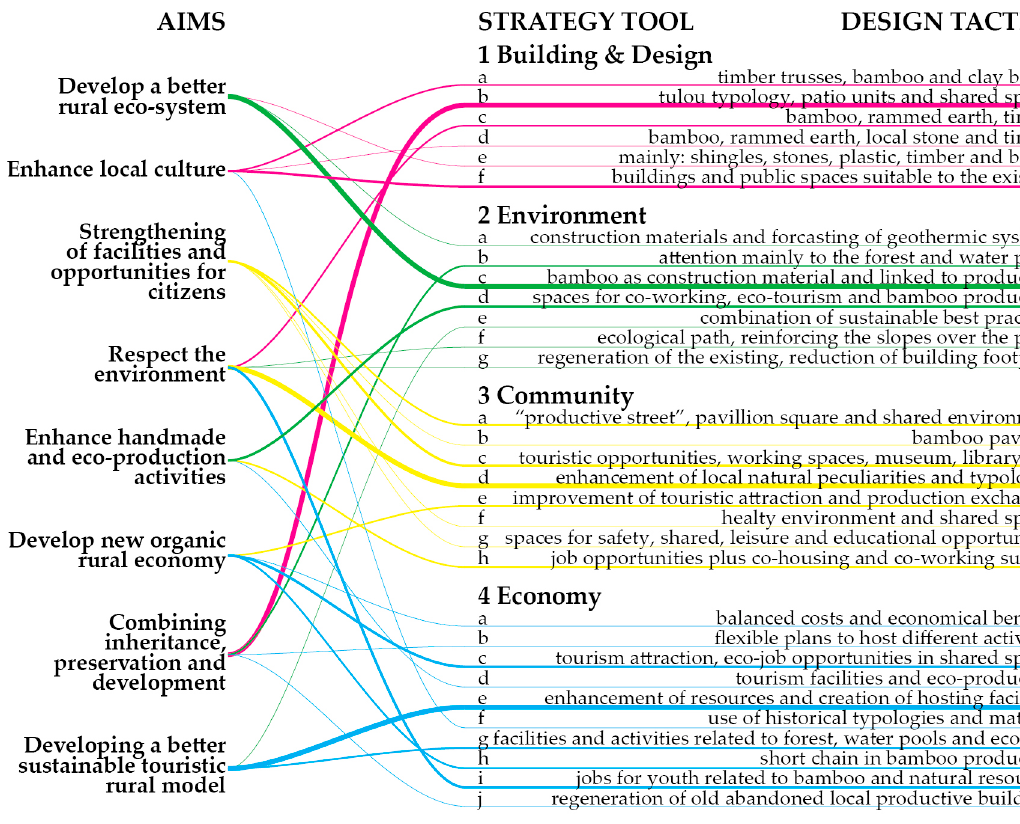
Figure 2. Diagram application of the strategy system tool. Meta-project 1.